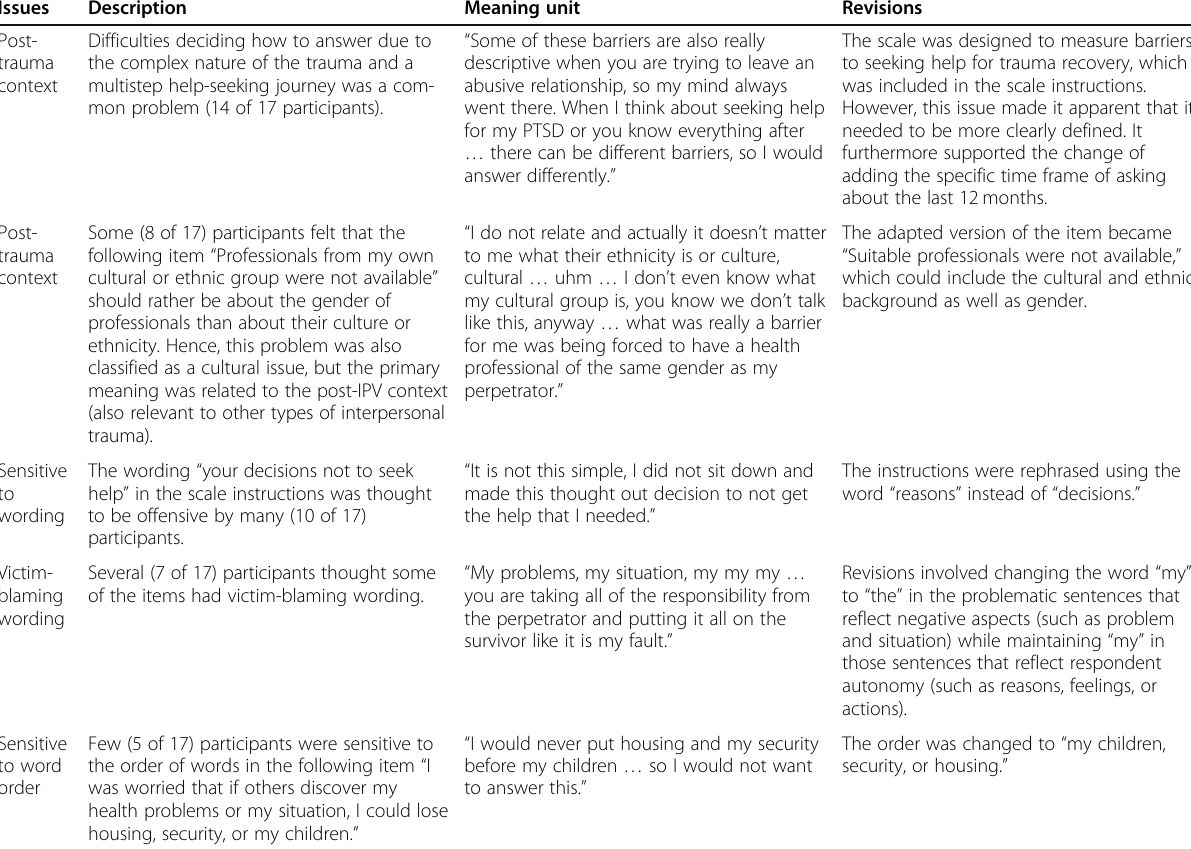
Table 7 Examples of trauma-specific issues